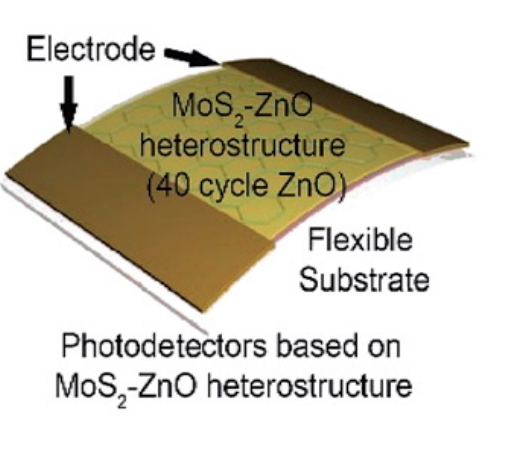
( c ) Figure 14. ( a ) Photodetector based on MoS 2 + HgTe; ( b , c ): responsivity and detectivity values over the vis-IR spectral range, respectively, for the same phototransistor. Reprinted with permission from ref. [35]. © 2017, John Wiley and Sons. A more recent work [54] has explored the deep UV spectral region reporting a pho- totransistor based on a thin MoS 2 film deposited on a flexible PET substrate, sensitized with ZnO nanoparticles (Figure 15a). The device showed a remarkable responsivity of 2.7 A/W to a 254 nm UV light source. Moreover, the performance was stable under multiple